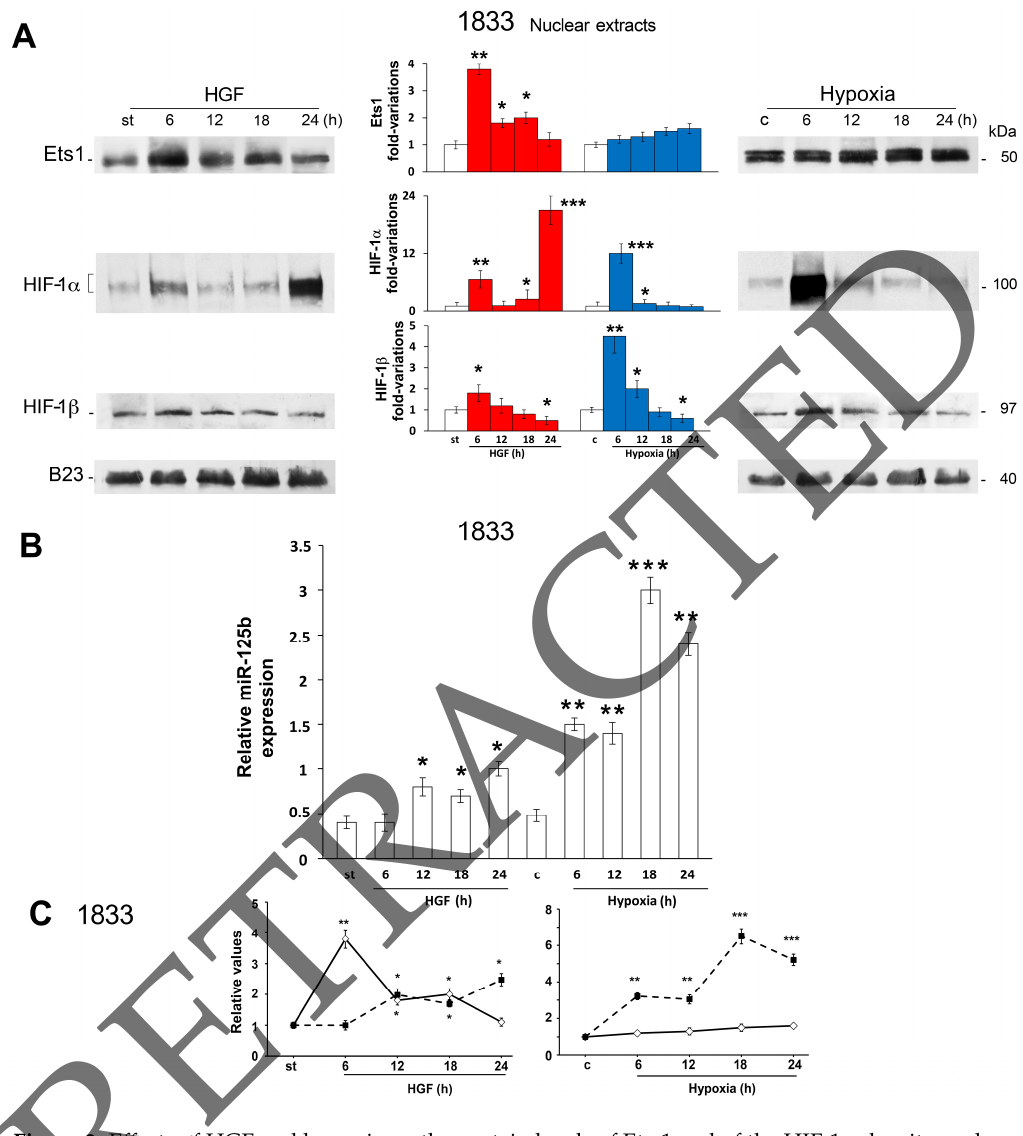
Figure 2. Effects of HGF and hypoxia on the protein levels of Ets-1 and of the HIF-1 subunits, and on the expression of miR-125b in 1833 cells. ( A ) Nuclear protein extracts from 1833 cells treated with HGF or hypoxia were analysed by Western blot, and immunoreactions were performed with the antibodies shown. B23 was used for normalization. The experiments were repeated three times, and the densitometric evaluation was performed. For each treatment and specific antibody used, the histograms show the means ± S.E. of the relative values, i.e., the fold variations versus the first bar (white) considered as 1. * p < 0.05, ** p < 0.005, *** p < 0.001 versus respective starvation (st) and control (c) values. Red, HGF; blue, hypoxia. ( B ) The expression of endogenous miR-125b was evaluated in 1833 cells treated with HGF or hypoxia, and the relative values were calculated using U6b as housekeeping gene. The experiments have been performed in triplicate, and the means ± S.E. are shown. * p < 0.05 versus starvation value; ** p < 0.005, *** p < 0.001 versus control value; ( C ) We show the time-courses of Ets-1 protein and miR-125b-expression levels: the data are the means ± S.E. * p < 0.05, ** p < 0.005, *** p < 0.001 versus respective starvation and control values. ◊ , Ets-1; ■ , miR-125b.